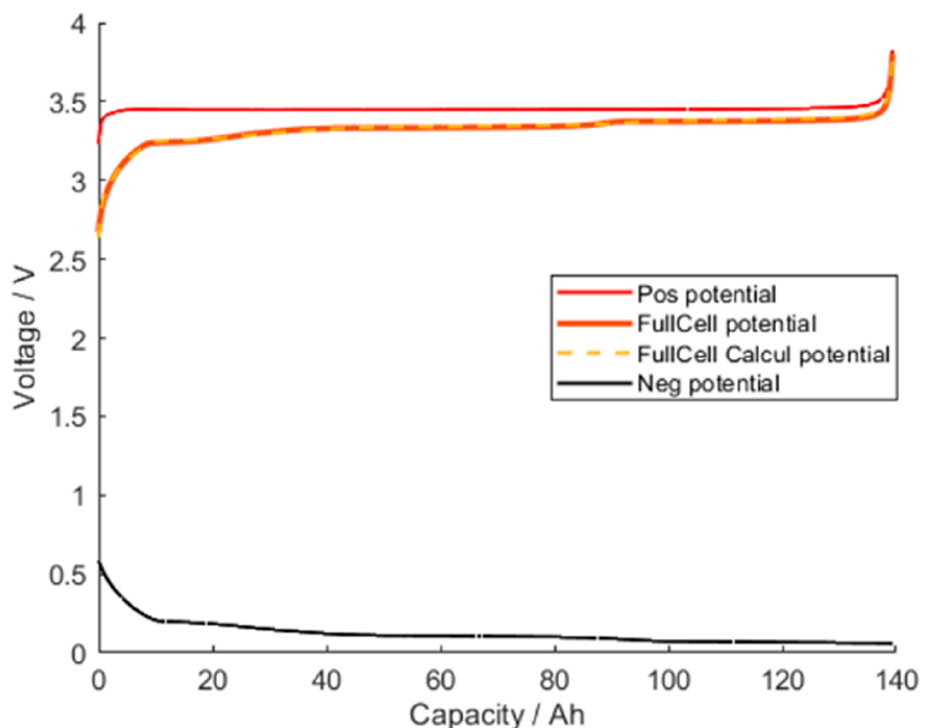
Figure 3. Identification results of Large-size battery dual tank model.